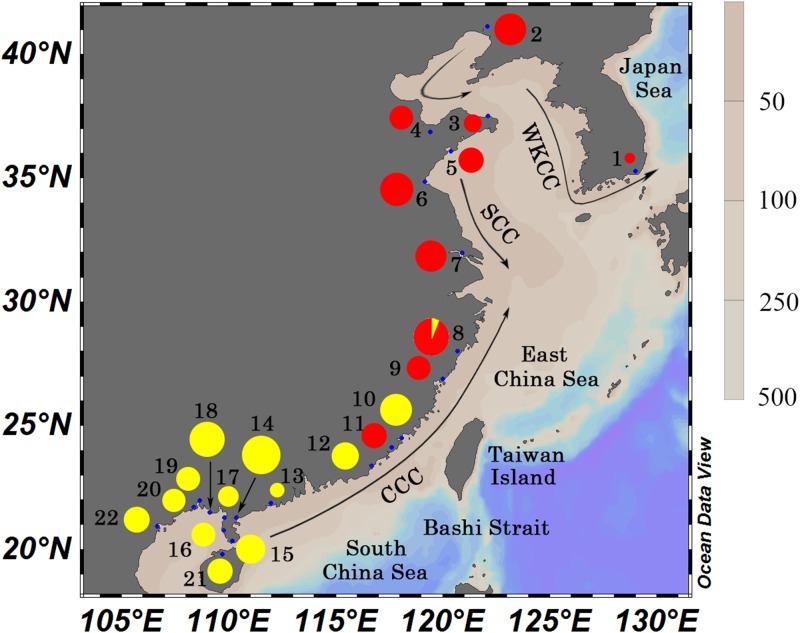
Map showing sample locations, spatial distribution of the two mitochondrial clades by pie diagrams for M. petechialis and the coastal currents in summer.Sampling sites are labelled with numbers in Table 1. Two lineages are color-coded separately: Red, North lineage; Yellow, South lineage. CCC, China Coastal Current; WKCC, West Korea Coastal Current; SCC, Subei Coastal Current. This map is rendered with ODV v4.7.6 [35].